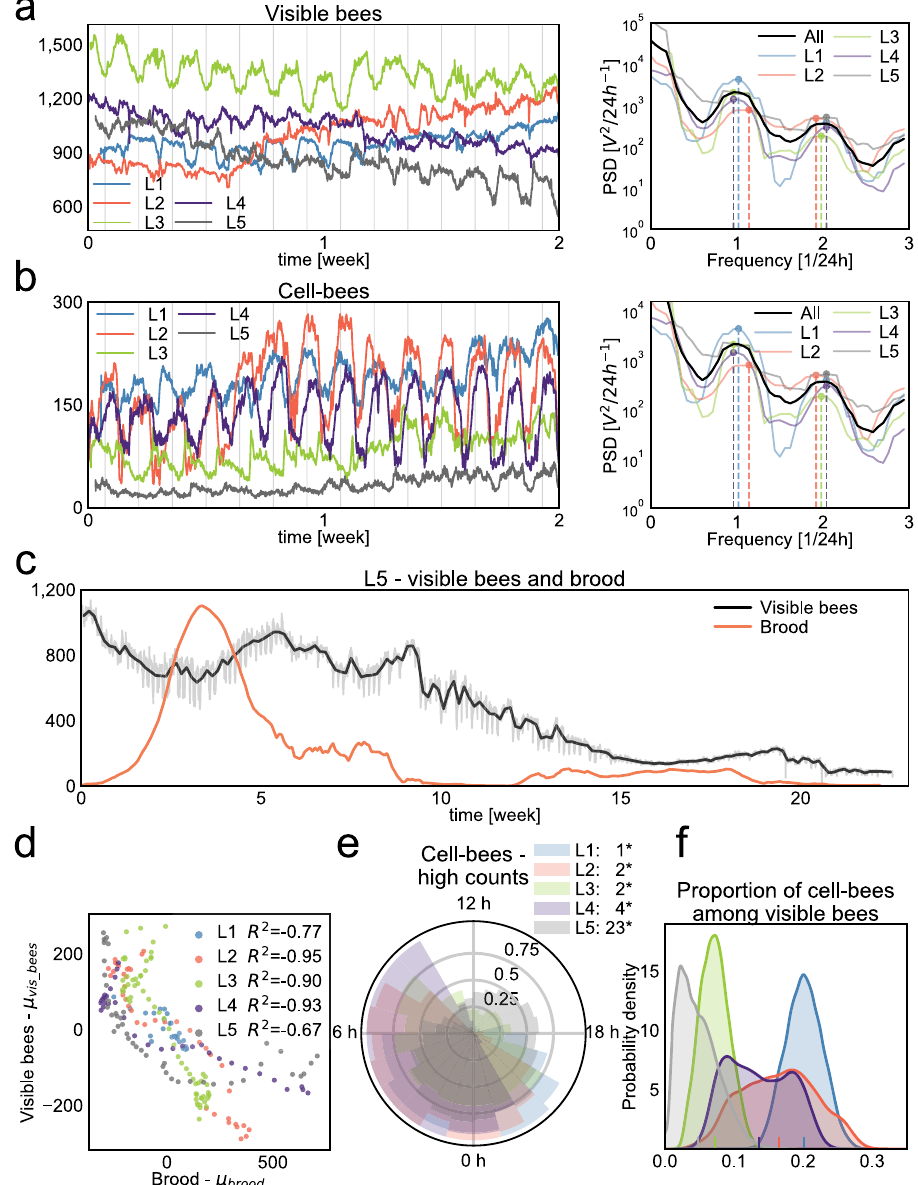
Fig. 3 Colony sociometry. a Daily fl uctuations of the visible bees (full-bees + cell-bees) in hives L1 – L5, where vertical lines denote midnight. The period of the fl uctuations is approximately 24 h in all hives, which is indicated by the power spectral density (PSD, right). Dashed lines in the PSD denote two highest values in the density plot of each hive. b Analogous to a , daily fl uctuations in the numbers of cell-bees and the respective power spectral density. c Visible bee numbers (full-bees + cell-bees, gray and black lines) and brood numbers (orange line) in bee colony L5. Colony L5 was imaged for over 4 months and exhibited a decline in bee numbers and ultimately colony collapse. After an initial rise in brood number, another increase of such amplitude did not occur, and the colony steadily declined from week 10. The black line indicates the daily average number of visible bees while the exact count in each image is shown in gray. d Bee and brood numbers are anticorrelated. Total bee number averaged over 12-h windows is plotted against the brood counts in the same time window in the fi ve colonies for the period of up to 3 weeks. For each time series, the mean of the series was subtracted from the plotted values. e The nightly presence of cell-bees. We divide each 24 h of a recording into 24 1-h bins and count how often the number of cell-bees is above the daily median number. Numbers in the legend indicate mean time of the day when the high counts are observed. Asterisk ( ‘ * ’ ) symbol marks hives where the observed high counts are not uniformly distributed based on p < 0.0001 in the Rayleight test of uniformity 97 . High numbers of cell-bees occur predominantly in the evening, between 21 h and 6 h. f Distribution of the proportion of cell-bees relative to the total number of visible bees in hives L1 – L5. Hive L3 and L5 show markedly lower proportion of cell-bees, which may be related to colony declines during our recording. Source data are provided as a Source Data fi Colony-wide tracking at single-organism resolution . Our high space and time. Quantitative visual features are extracted from a CNN 52 trained using a triplet loss objective function 69,70 — a detection accuracy provides a strong foundation for reliably fol- function which enables the expression of similarity among enti- lowing objects in time. Rather than focus on distinct markers of ties via their vector embeddings. During training, triplets of each individual 47 – 49 , we apply a rich representation of visual images are fed into the network and we search for a solution features to explicitly resolve confounding trajectories locally in